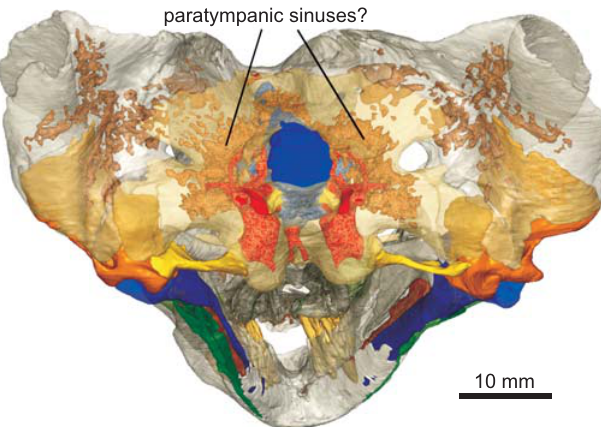
Fig. 3. Distribution of cavities in the otic region of the non-mammalian synapsid Pristerodon mackayi Huxley, 1868 (MB.R.985) from the Late Permian of Biesjespoort, South Africa. Note the concentration of a number of large cavities (brown) around the inner ears, which are connected to each other. The neurocranium is shown transparent.